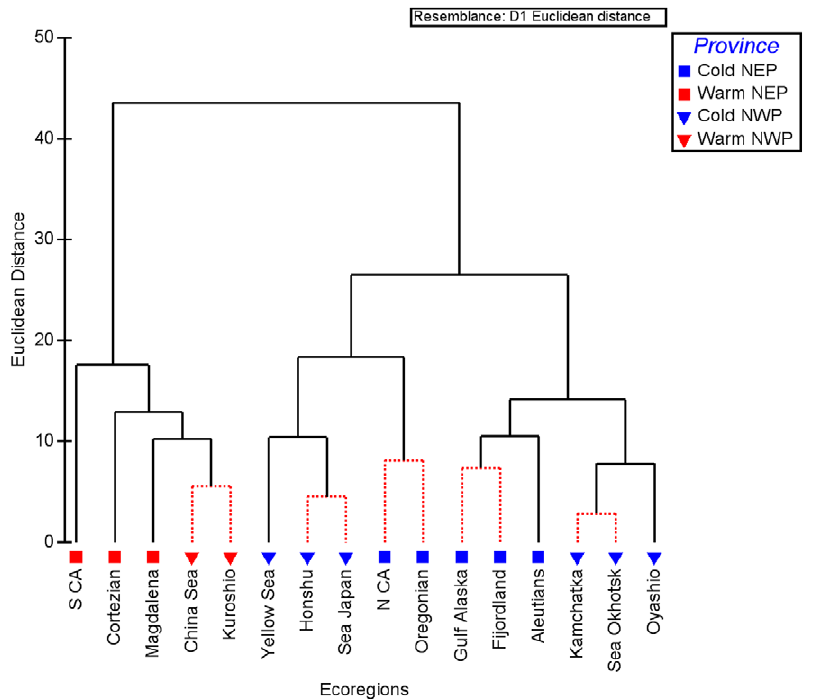
and the Yellow Sea, deviate substantially from the line, while less variable ecoregions lay closer to the line. At the same time, similarity among ecoregions in overall seasonal patterns is